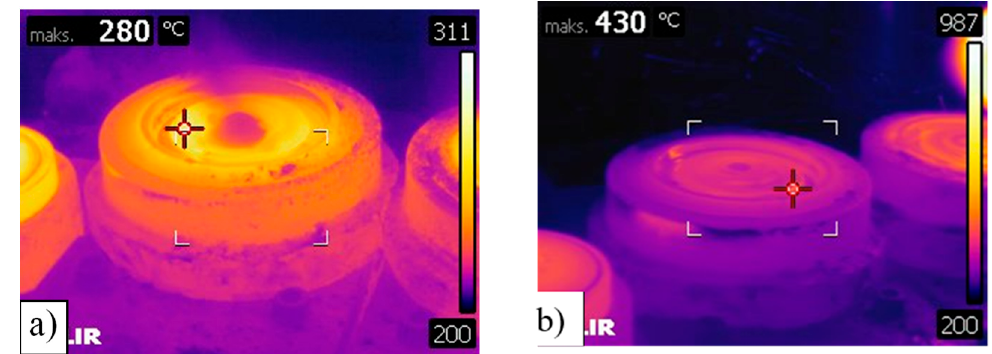
Figure 5. Thermogram of the die working surface: ( a ) Just before forging, after lubrication and cooling; ( b ) immediately after removing the forging from the die surface.